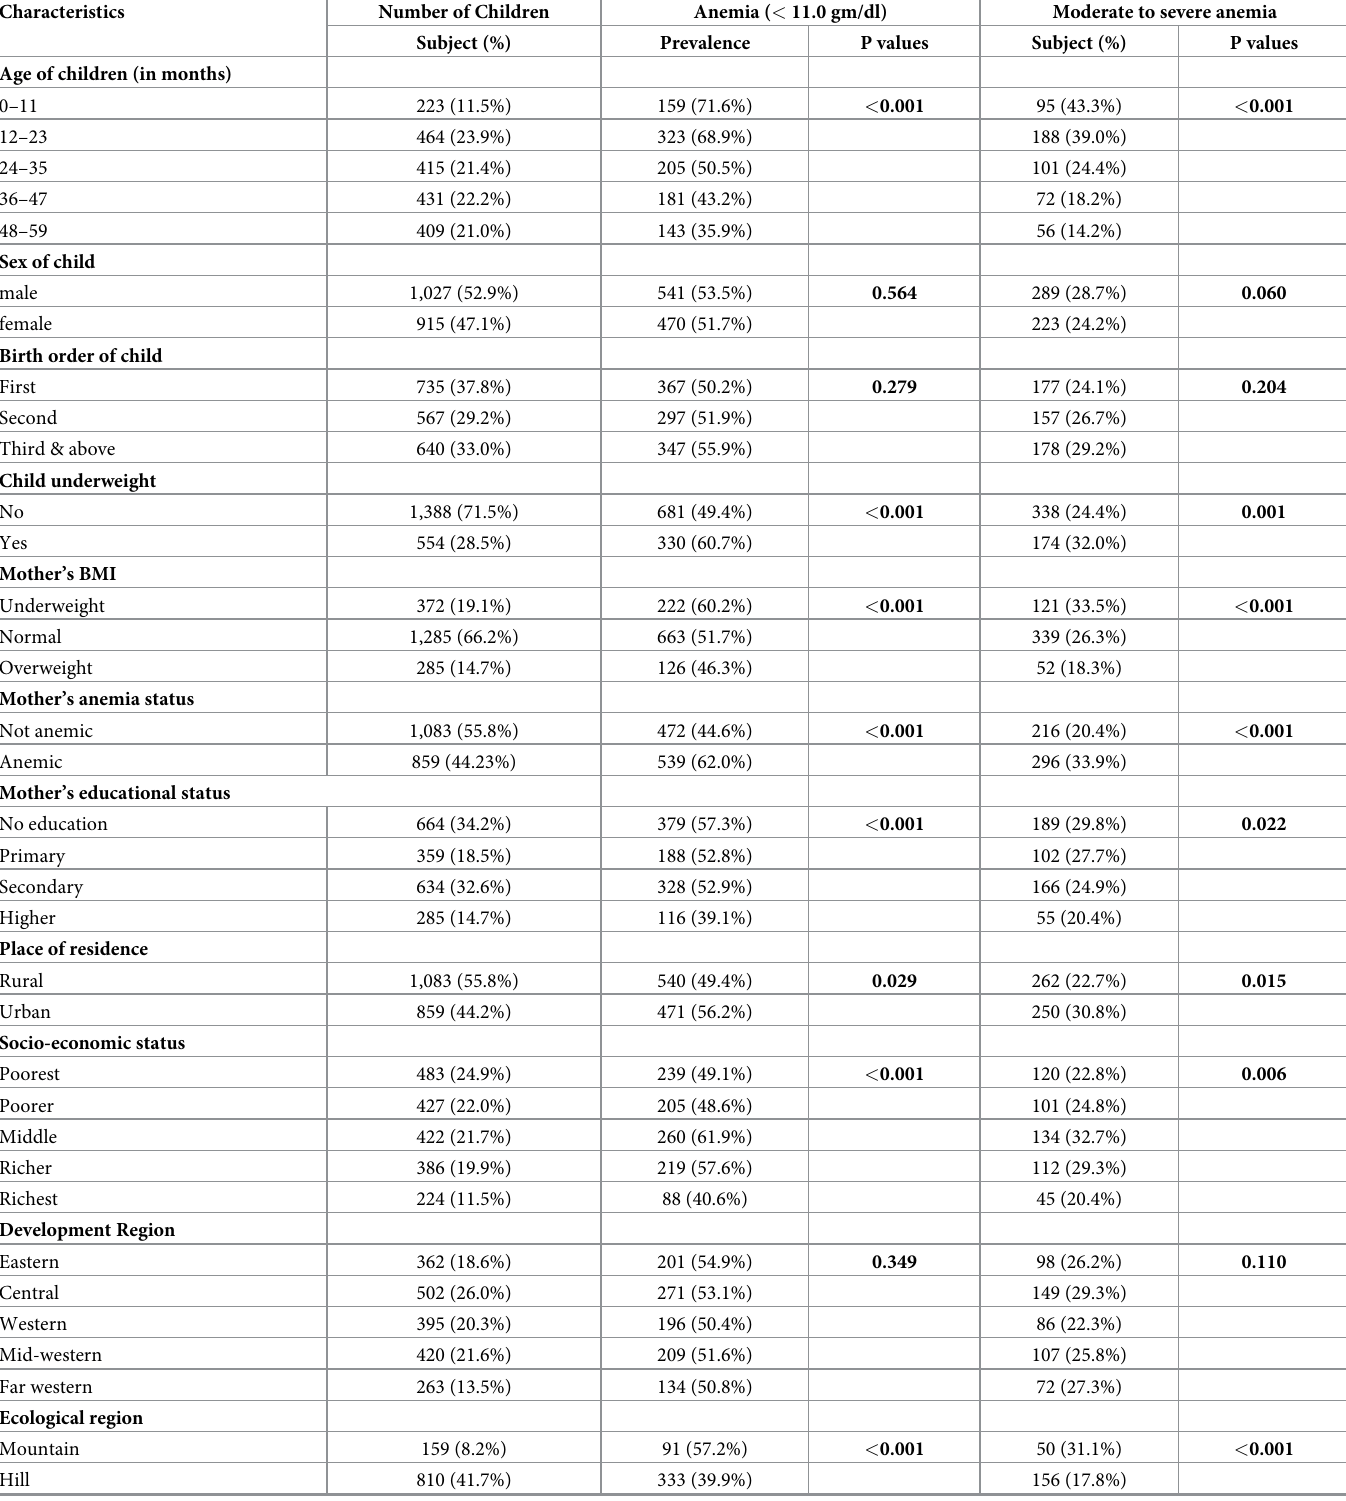
Table 1. Prevalence of any level of anemia ( < 11.0 gm/dl) and moderate to severe anemia among children under 5 years of age (N = 1,942).